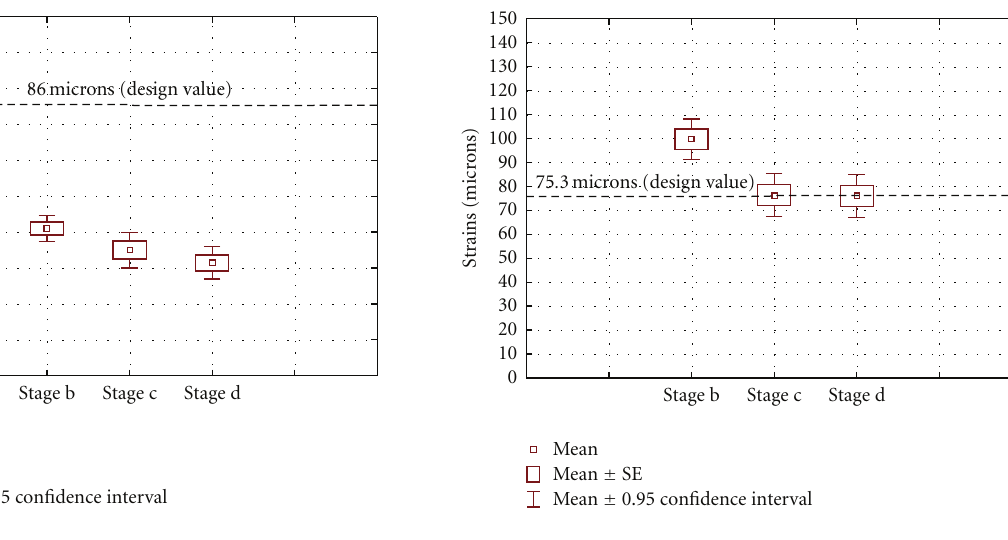
Figure 18: Average strains on the